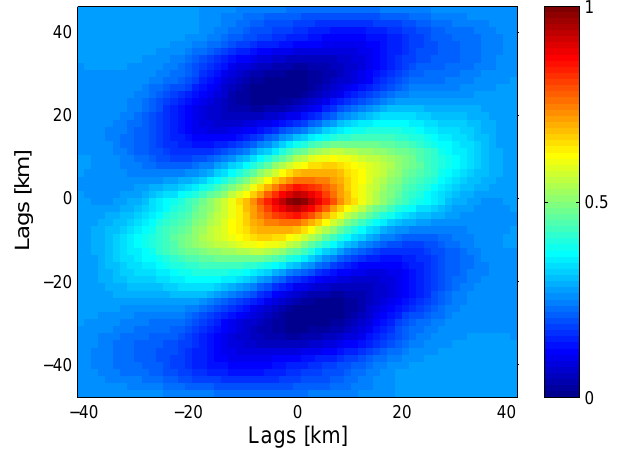
Figure 5. Spatial autocorrelation function for a PWV map, with the long-wavelength component removed, computed from remote sensing data acquired on 5 September 2005, 10:51UTC.